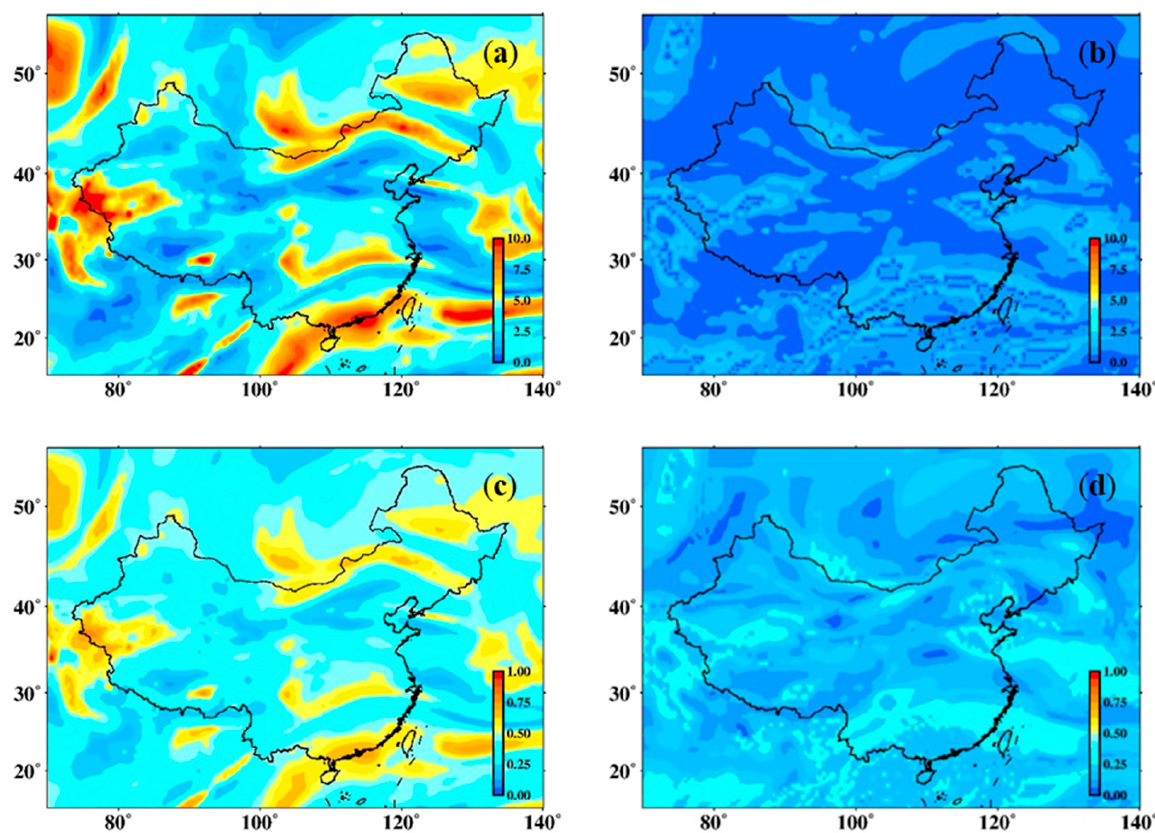
Figure 5. SD distribution (linear ( a ) and nonlinear ( b )) and RMS distribution (linear ( c ) and nonlinear ( d )) of all grid points in the study area.